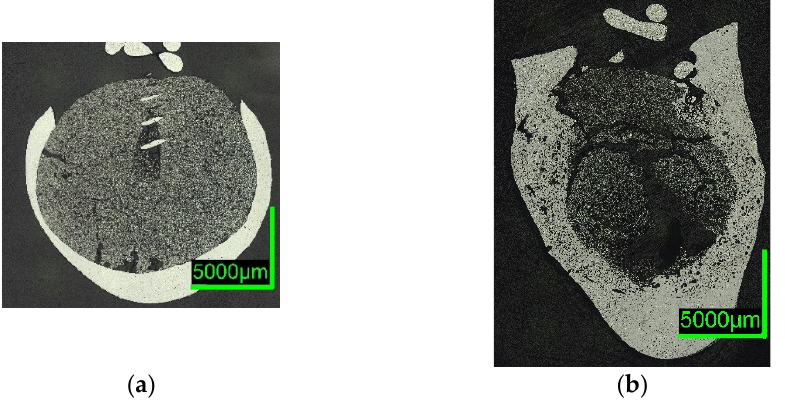
Figure 7. Digital microscope images of ( a ) 0%C-ULC-1; ( b ) 0%C-ULC-10s-3, dipped into liquid ULC steel.